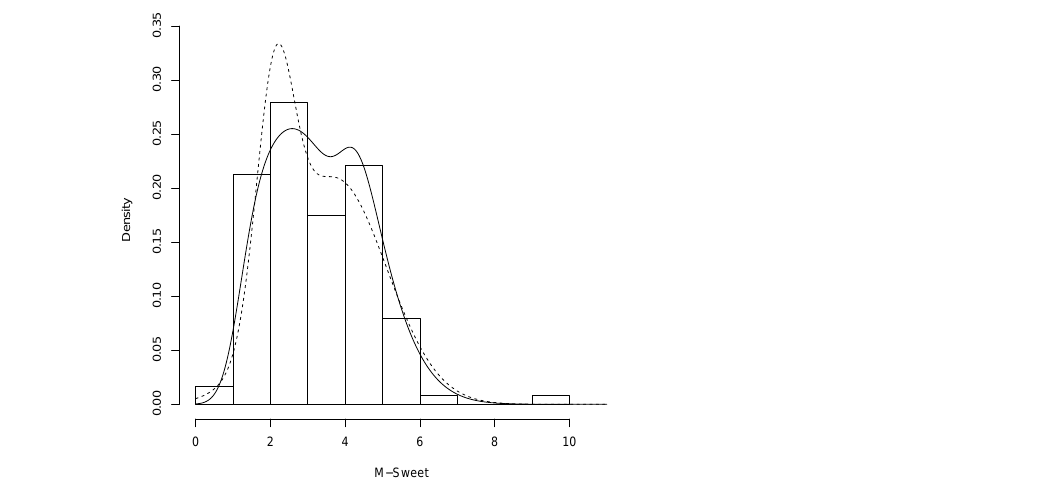
Figure 5. MN distribution (dashed line) and GSN distribution (solid line) for the M-Sweet data.